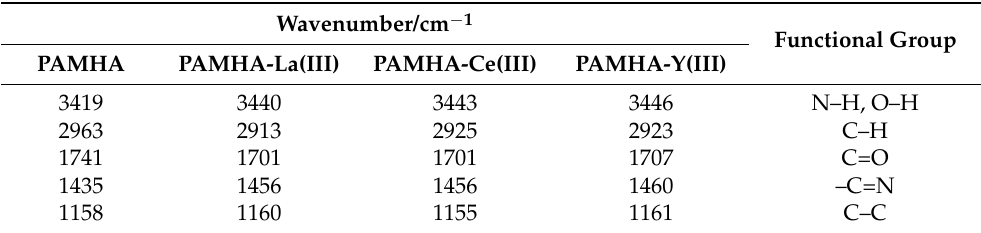
Table 3. The functional groups correspond to the peaks in Fourier transform infrared spec- troscopy (FTIR).